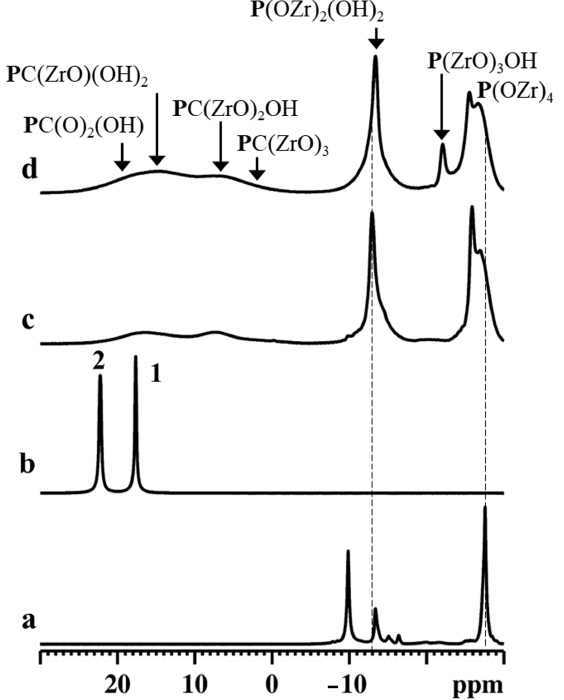
Figure 6. 31 P MAS NMR spectra of γ ZP (a), ALN-Na (b), γ ZP05 (c), and γ ZP1 (d). A MAS rate of 15 kHz was employed during the experiments.